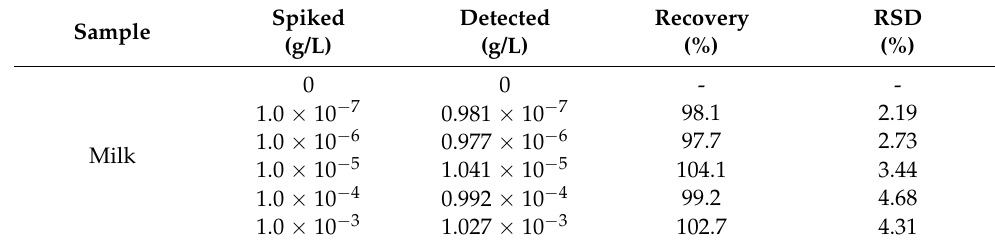
Table 2. Recovery rates and RSD with different concentrations of CAP in milk samples ( n =